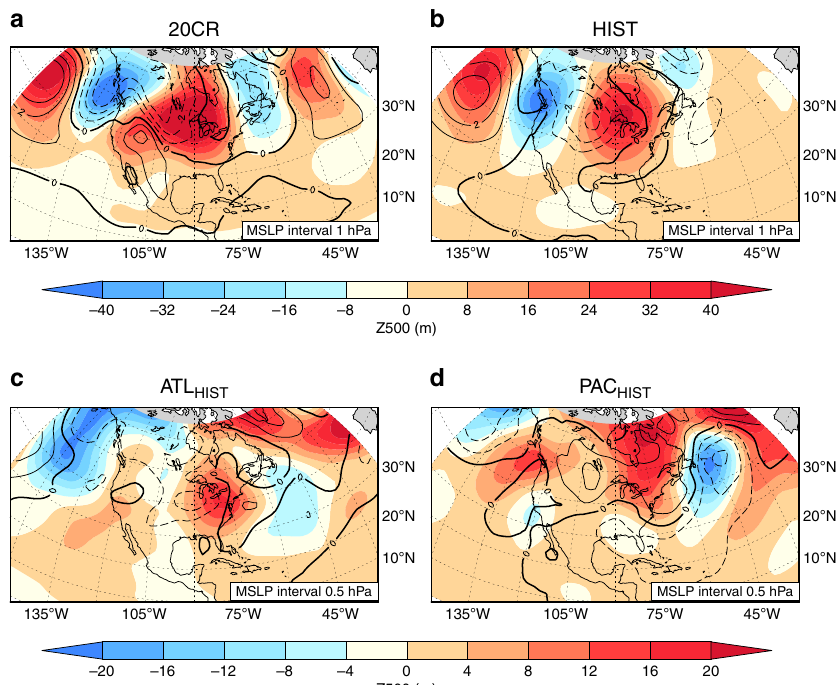
Fig. 3 Atmospheric conditions during the hottest Dust Bowl heatwaves. The spatial patterns of mean sea-level pressure (MSLP; colours) and geopotential height at 500 hPa (Z500; contours), averaged over a 7-day period from the start of the hottest summer heatwave over the central US, and averaged over 1930 – 1937. Shown are the twentieth century reanalysis version 2c (20CR; a ), a ten-member Hadley Centre Global Environment Model version 3 (HadGEM3) historical sea surface temperature (SST) ensemble mean (HIST; b ), a fi ve-member Atlantic SST ensemble mean (ATL HIST ; c ), and a fi ve-member Paci fi c SST ensemble mean (PAC HIST ; d ). The thick line indicates the 0 hPa MSLP anomaly, while the solid (dashed) lines indicate positive (negative) MSLP